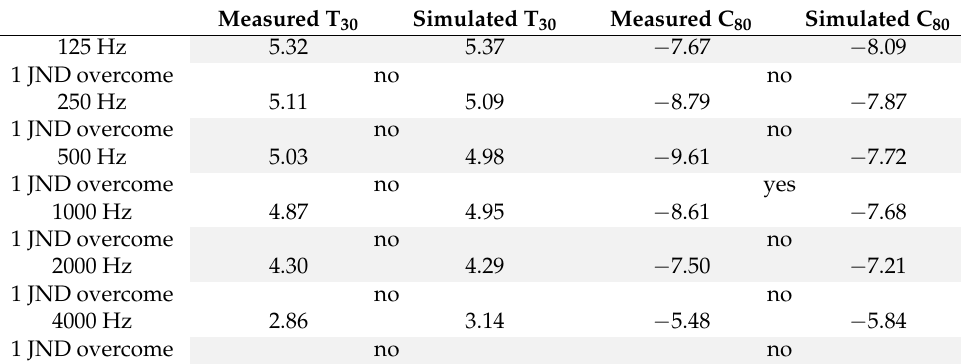
The calibration of the numerical model by means of measured and simulated values comparison.